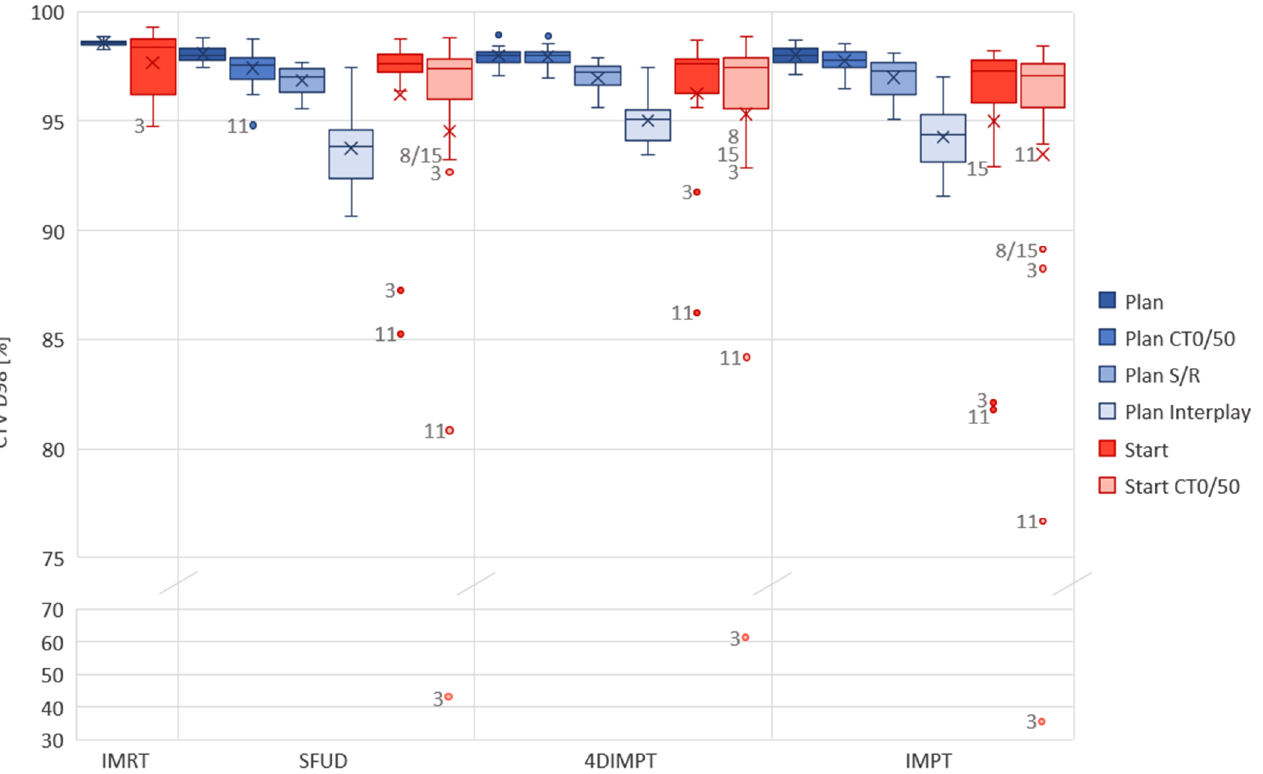
Figure 3. Robust evaluation on the Plan (blue) and Start (red) CTs for each optimization technique. The acceptance criteria were D 98% > 90% for interplay evaluation and >95% for other robust evalua- tions. In cases where the criteria were not met, the patient number is given next to the observation in the figure. DIBH CT was used in IMRT for patients 3 and 11, hence planning and recalculation were not performed on the same scans as for the PT plans. CT0/50 includes two observations (both extreme phases) per patient. Boxplots show the median (line), mean (cross) and spread, with outliers as dots outside the box. Plan = planning CT, Start = start of treatment CT, CT0/50 = extreme phase evaluation, S/R = setup and range evaluation.